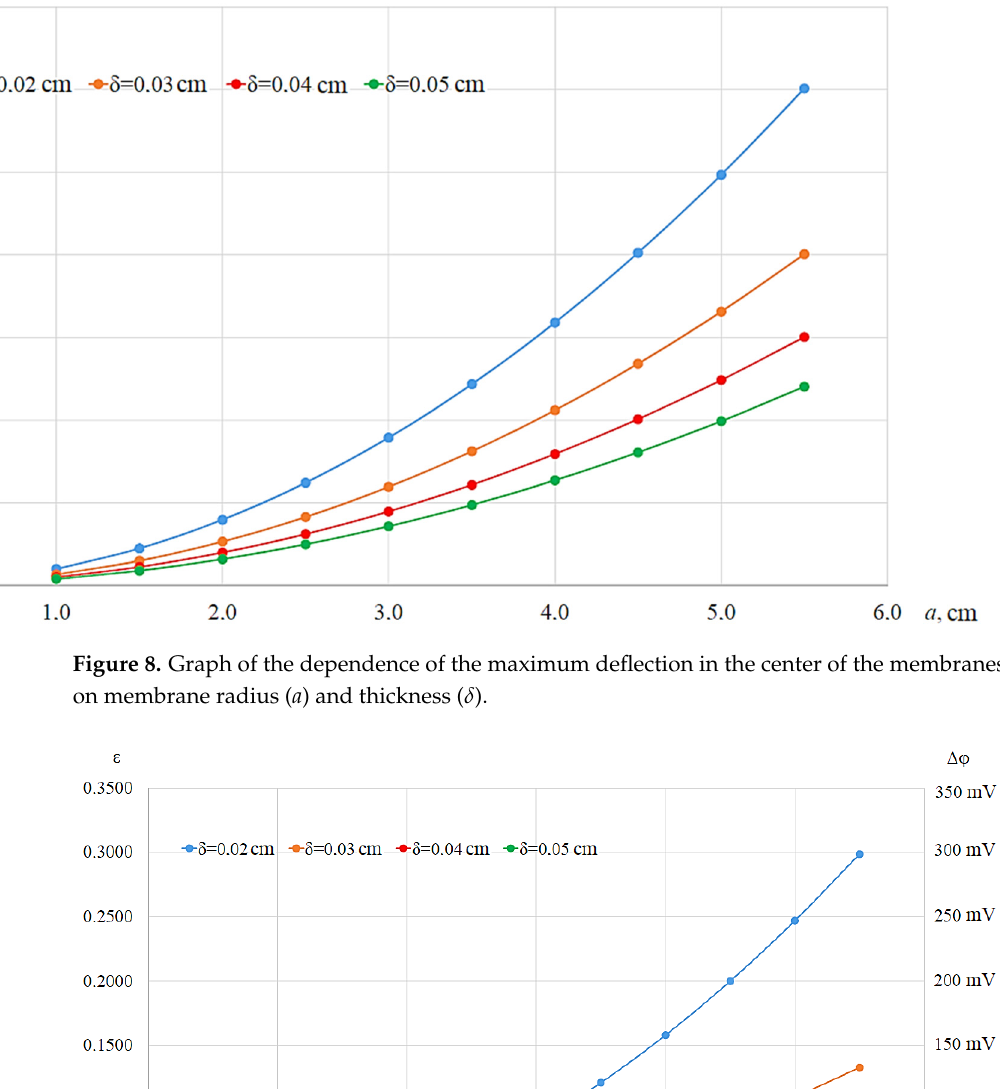
Figure 10. Graphical analysis of displacements in membranes.